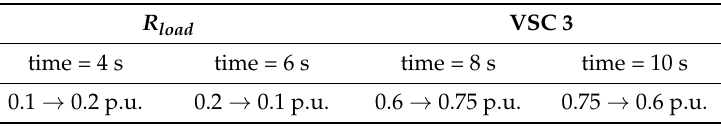
Table 6. Loading Sequence in the MTDC